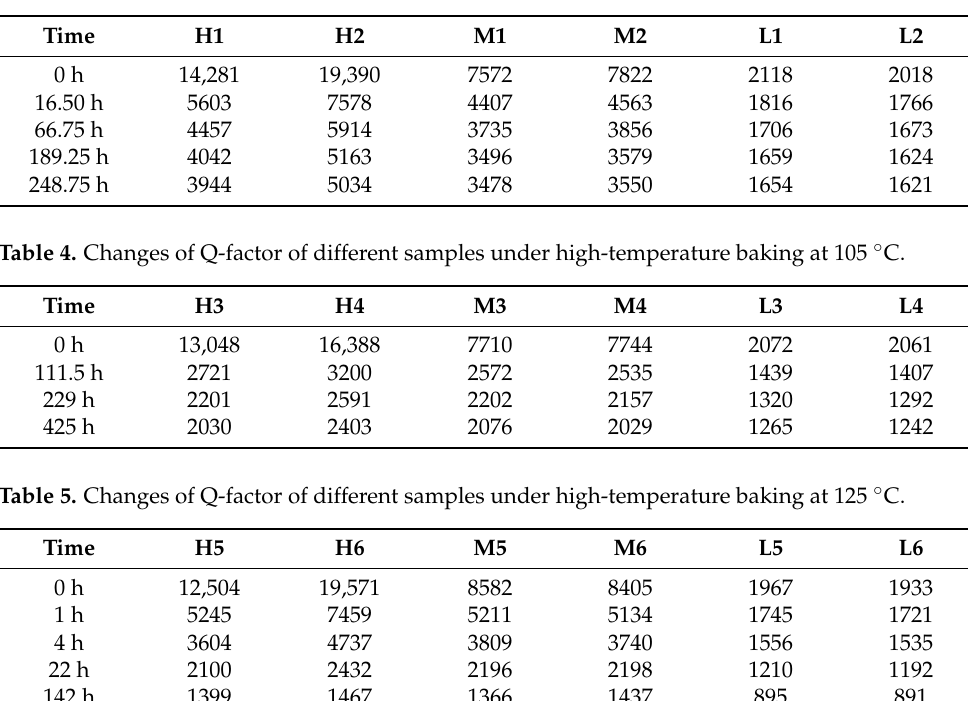
Table 3. Changes of Q-factor of different samples under high-temperature baking at 85 ◦ C.